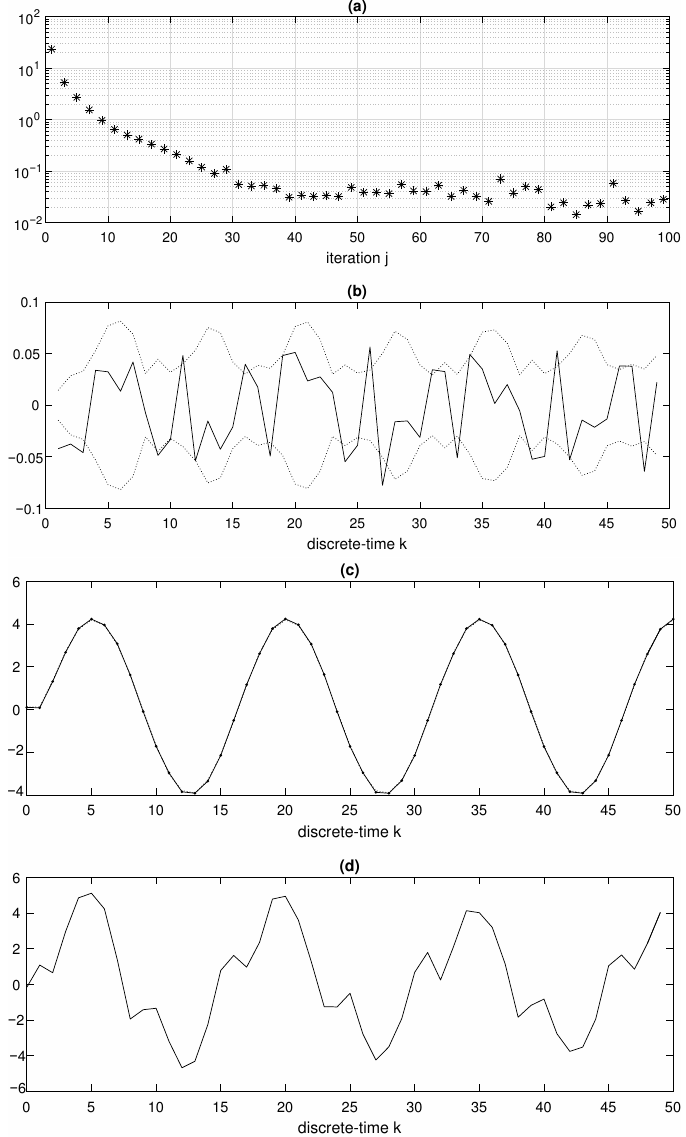
( k ) | ( ∗ ) versus iteration j . ( b ) e 100 ( k ) (solid line) and φ 100 ( k ) , − φ 100 ( k ) Figure 1. ( a ) max k ∈{ 1, ··· ,50 } | e j φ ( k ) (dotted line) versus discrete-time k . (dotted lines) versus time k . ( c ) y 100 ( k ) (solid line) and y 100 d ( d ) u 100 ( k ) versus discrete-time k